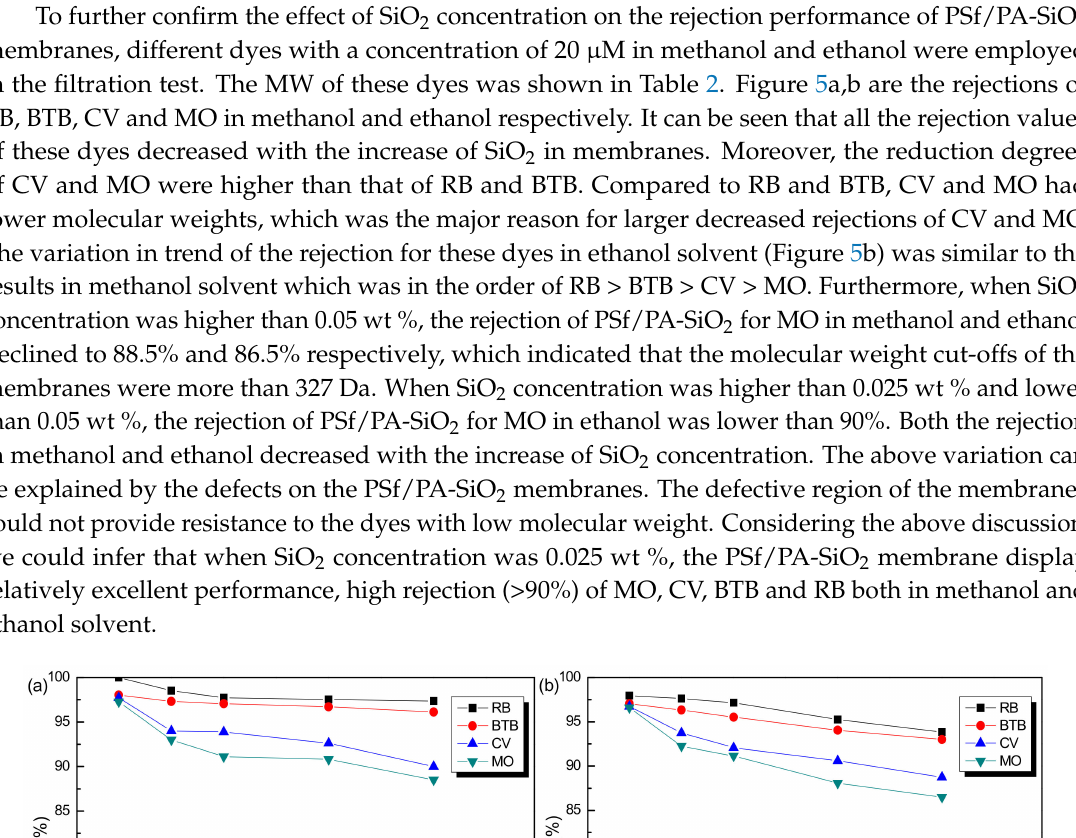
Figure 4. Normalized permeance and rejection of PSf/PA and PSf/PA-SiO 2 membranes in ( a ) RB/methanol solvent and ( b ) RB/ethanol solvent.